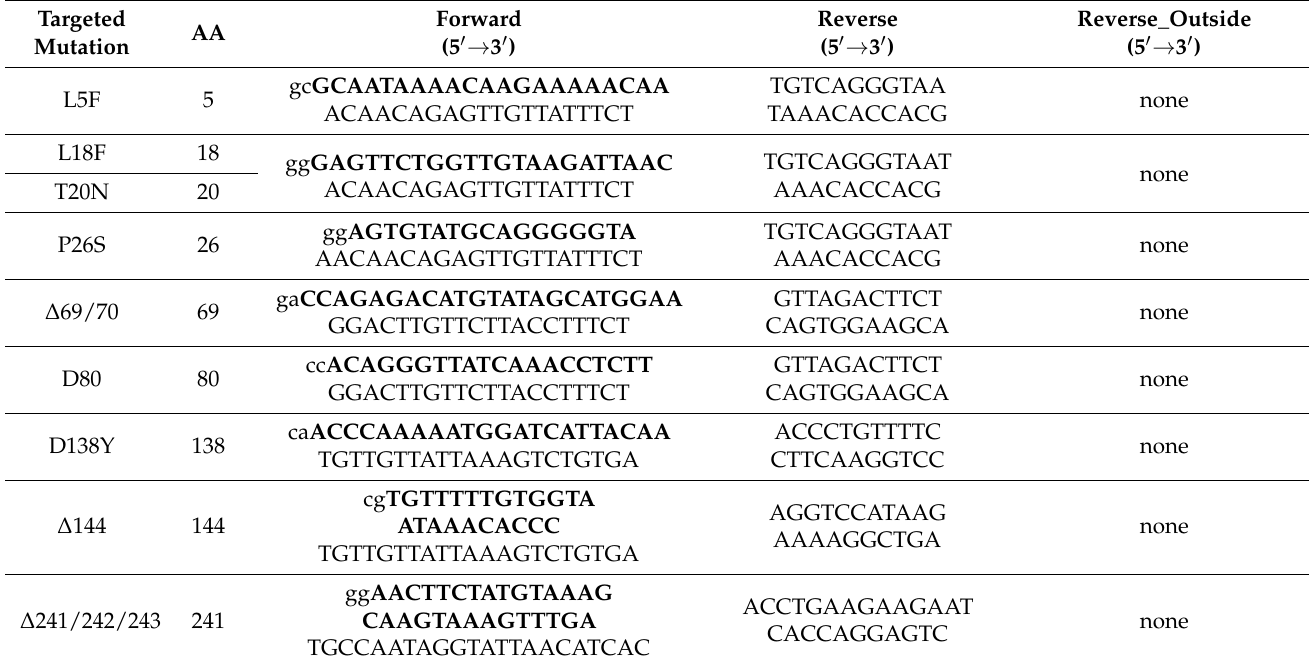
Table 2. Primers used in this